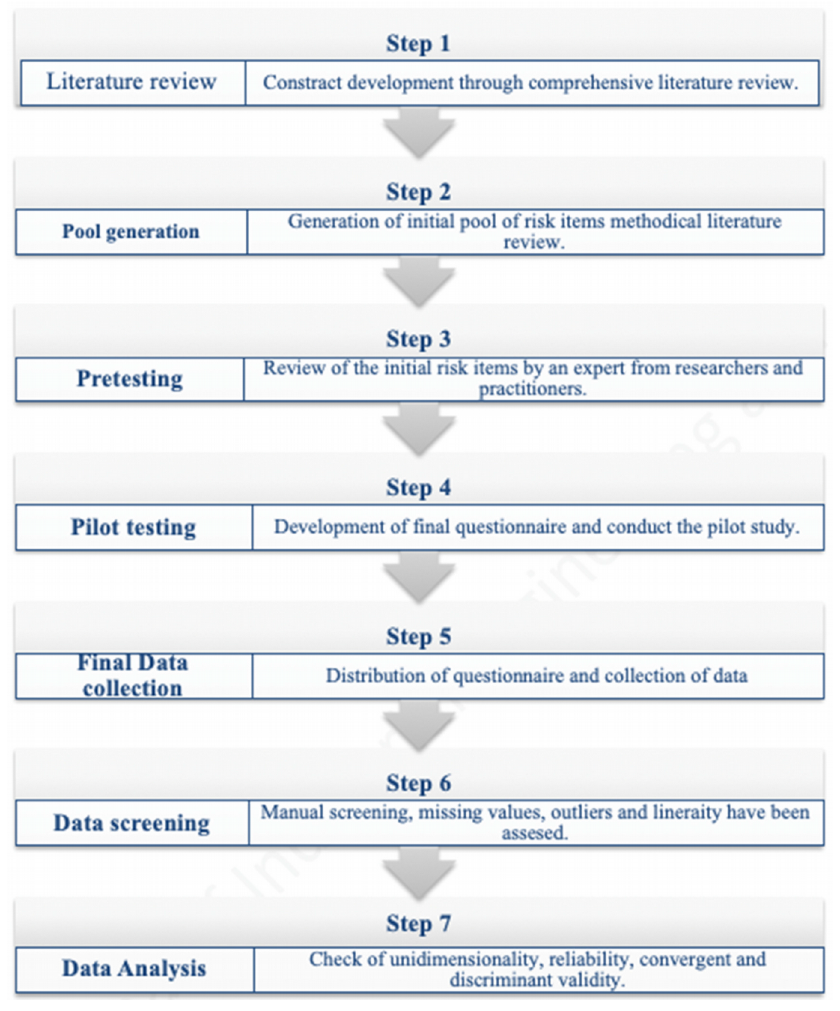
Figure 3. Instrument development process (Punniyamoorthy et al.,